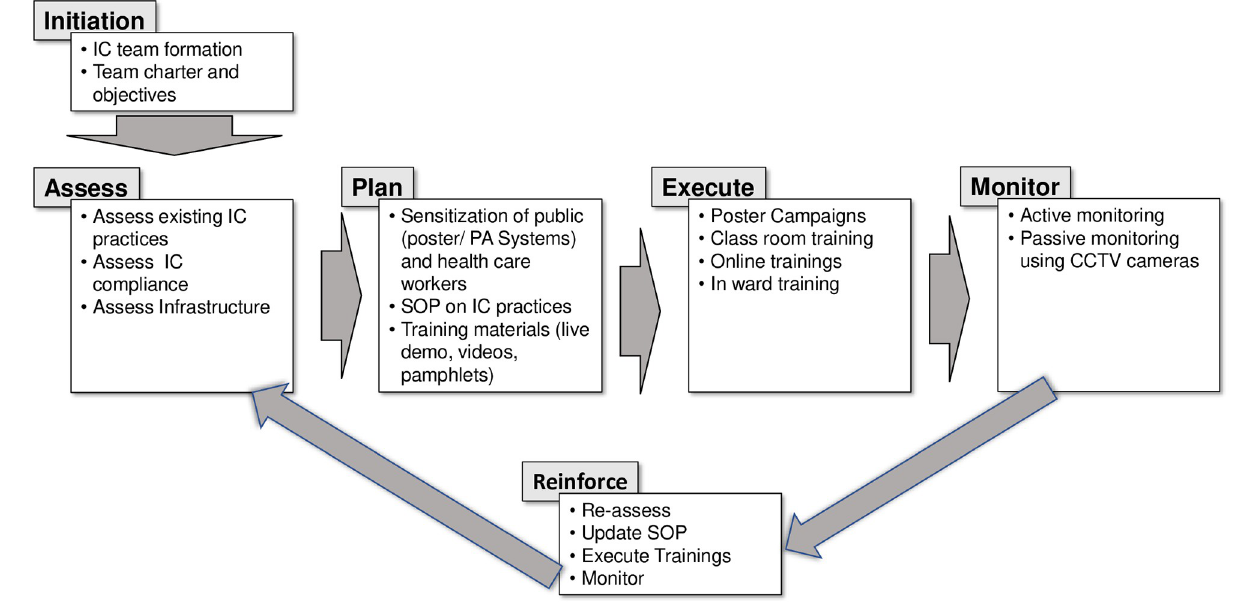
Fig 1. Approach to IPC implementation with specific activities at different phases of